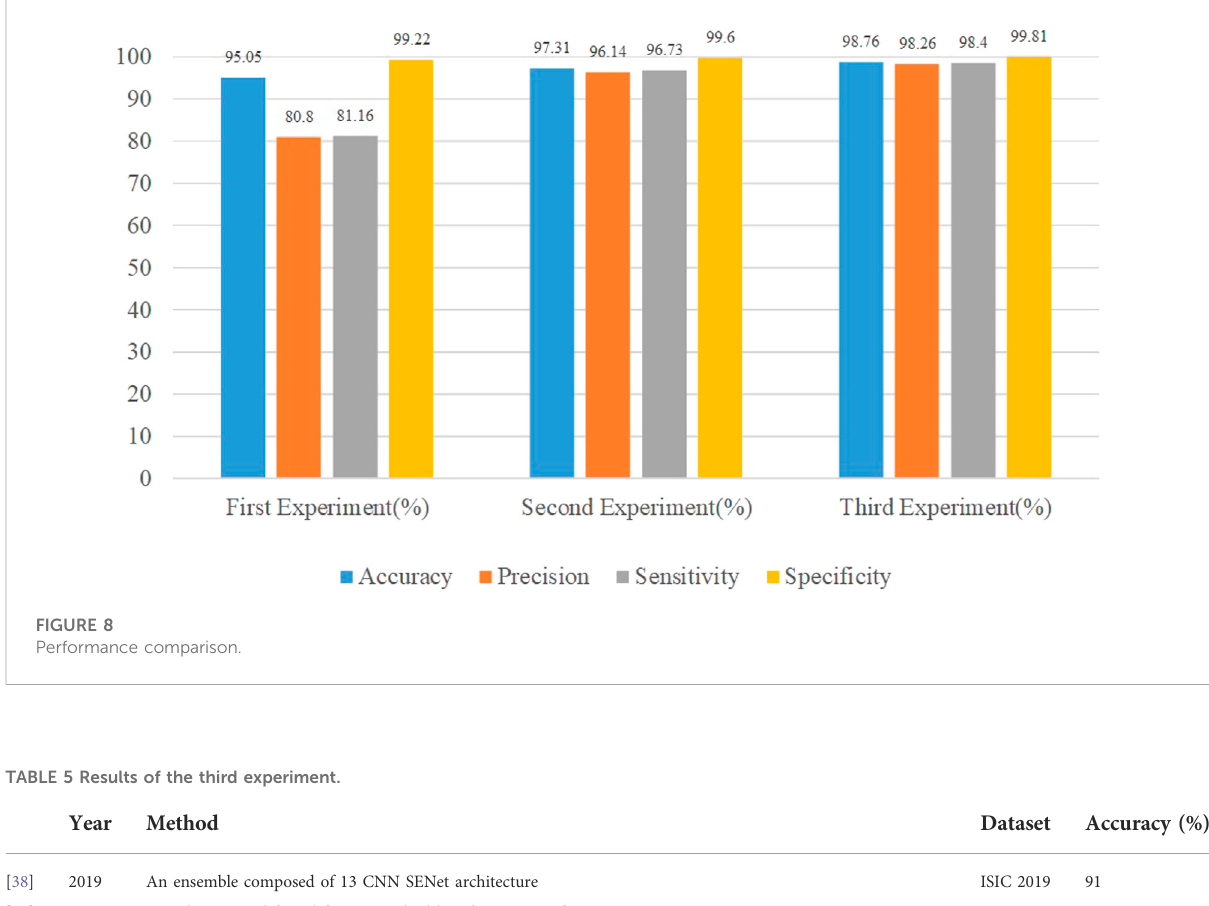
TABLE 5 Results of the third